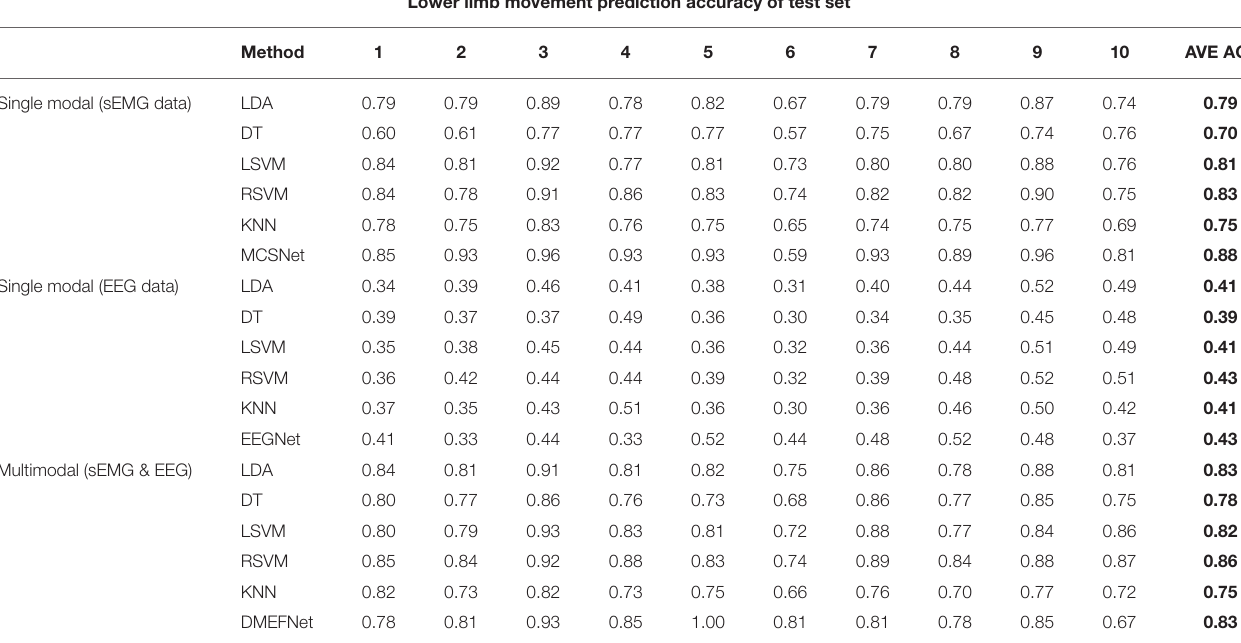
TABLE 1 | Within-subject movement prediction performance (Test set ACC). Lower limb movement prediction accuracy of test set